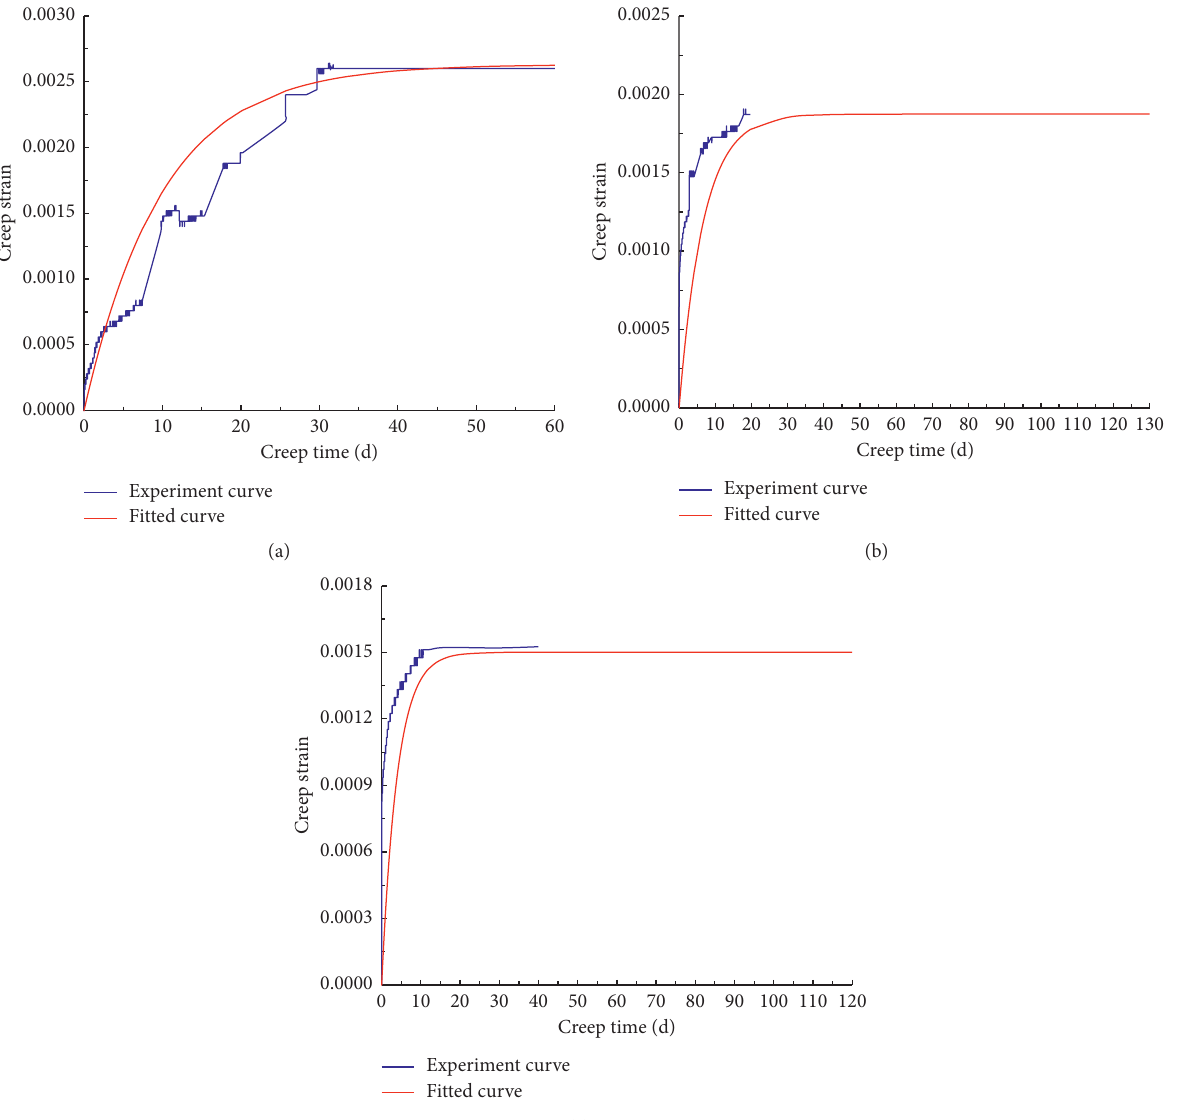
Figure 7: (a) Fitting creep curve of medium-grained sandstone specimens. (b) Fitting creep curve of untreated CGB. (c) Fitting creep curve of CGB specimens soaked in